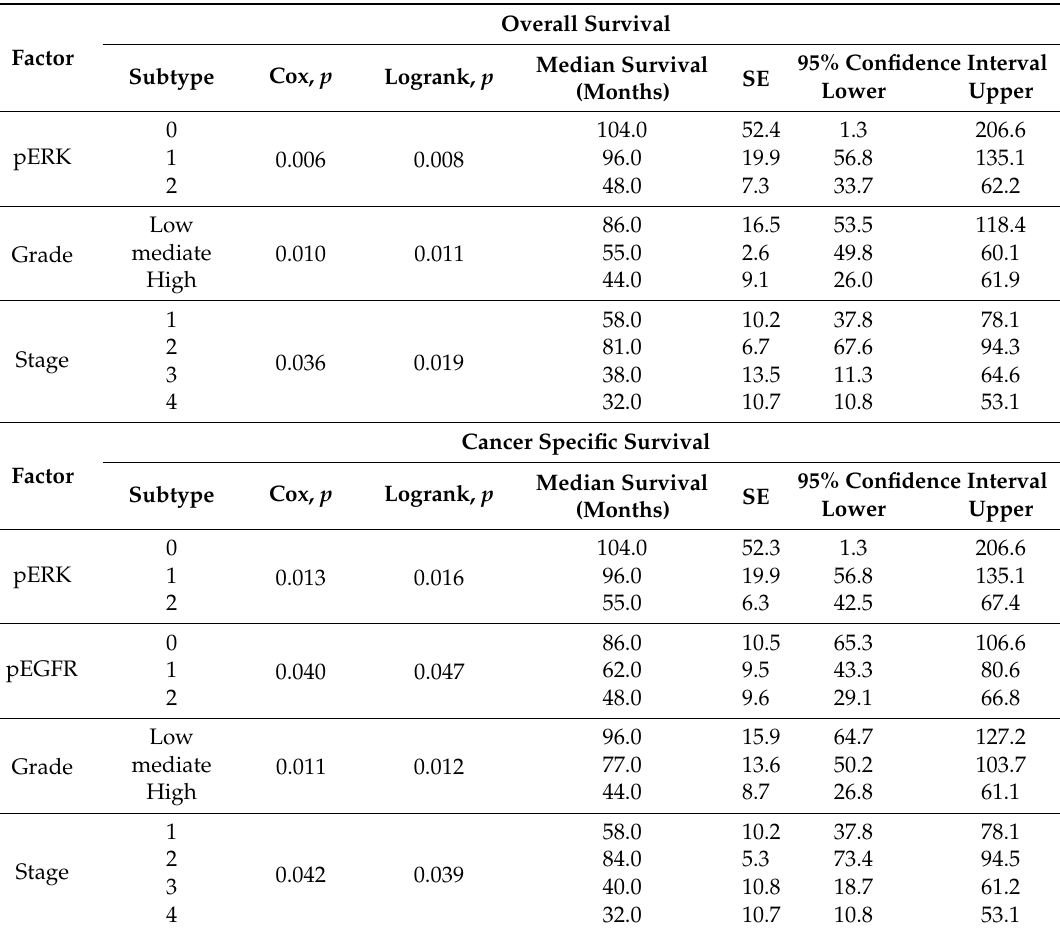
Table 3. Independent prognostic factors for patient